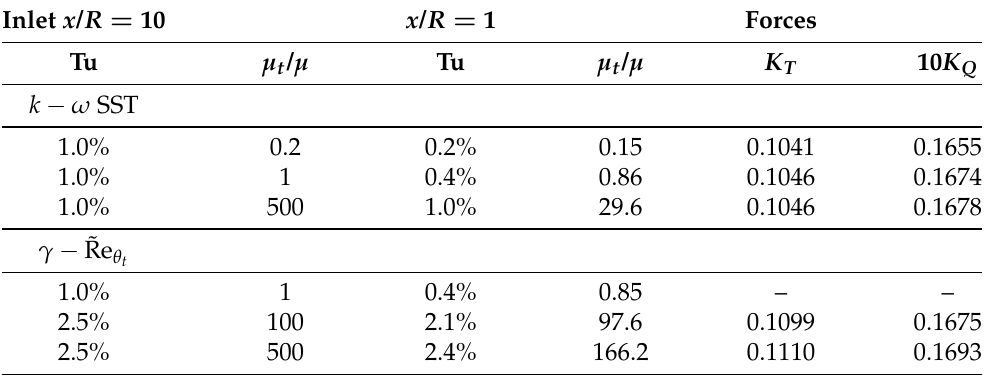
Figure 8. Iterative convergence of K T ( left ) and 10 K Q ( right ) at J = 0.568 using the γ − ˜Re θ model at Re = 1 × 10 5 with Tu = 1.0% and µ t / µ = 1 for J = 0.568. Table 5. Influence of the inlet turbulence quantities on the propeller forces at Re = 1 × 10 5 for J = 0.568. Turbulence intensity at x / R = 1 refers to section r / R = 0.7.